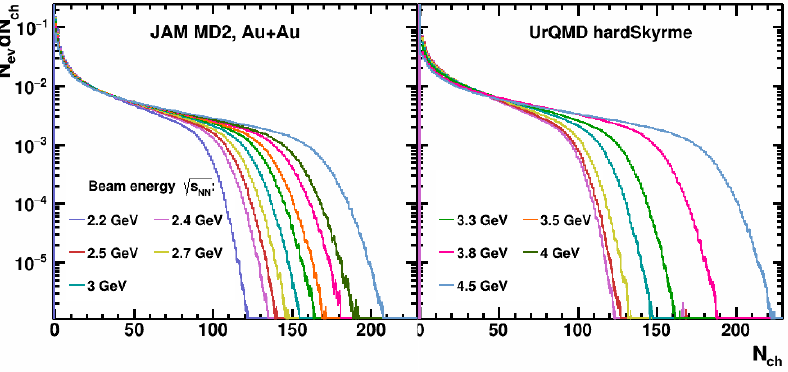
Figure 1. The reference multiplicity distributions of charged particles for Au + Au collisions at √ s NN = 2.2–4.5 GeV for the mean-field mode JAM ( left ) and UrQMD ( right ) models. energies As an example, Figure 2 shows the reference multiplicity distributions of charged √ s NN = 4.5 GeV for the DCM-QGSM-SMM (left panel), particles for Au + Au collisions at UrQMD (central panel) and JAM MD2 (right panel) models compared to those from Monte Carlo (MC) Glauber simulations (blue line) [29]. A total of 10% centrality classes are indicated with black vertical lines in Figure